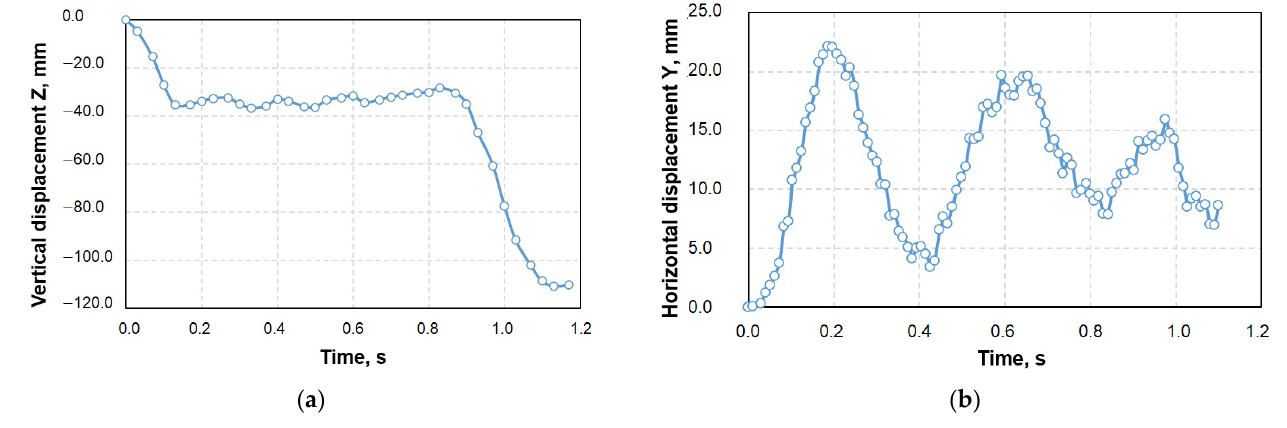
Figure 9. Displacement history of joint D for the Z direction ( a ) and of joint C for the Y direction ( b ).